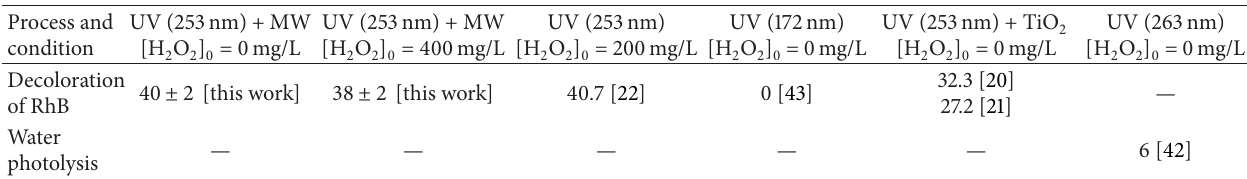
Figure 8: Semilogarithmic plot of the absorbance at 554 nm versus irradiation time of RhB solution (10.2mg/L) without hydrogen peroxide (a) and with hydrogen peroxide (400mg/L) (b), at various MW powers and temperatures (UV emission constant). Lines are the linear fitting of the ln(absorbance) data. Table 2: The apparent activation energy results